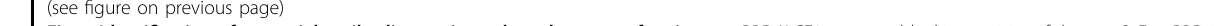
Fig. 1 Identi fi cation of potential antibodies against a broader array of variants. a RBD/ACE2 receptor blocking activity of the 177 ScFvs. RBD is from the original wild-type (WT) strain. Group 1: immunization with RBD protein and screening with RBD protein; Group 2: immunization with RBD protein and screening with Spike protein; Group 3: immunization with Spike protein and screening with RBD protein. OD 450 < 2.3 in the ELISA-based receptor-binding inhibition assay was de fi ned as “ positive ” and OD 450 > 2.3 was de fi ned as “ negative ” . b Blocking ACE2 receptor binding to RBDs of original WT strain, beta and delta strain by the 177 mAbs. mAbs were diluted as 0.25, 1, 4 μ g/mL. These mAbs were grouped into seven families by heavy chain CDR3 sequence homology. c Neutralization activity of the 22 mAbs in 0.19 μ g/mL using vesicular stomatitis virus (VSV) pseudotyped with Delta Spike protein was shown for preliminary screening. 8 mAbs were selected to test neutralization activities using VSV pseudotyped with Delta, Beta, or Kappa Spike protein for further screening, and IC 50 values were